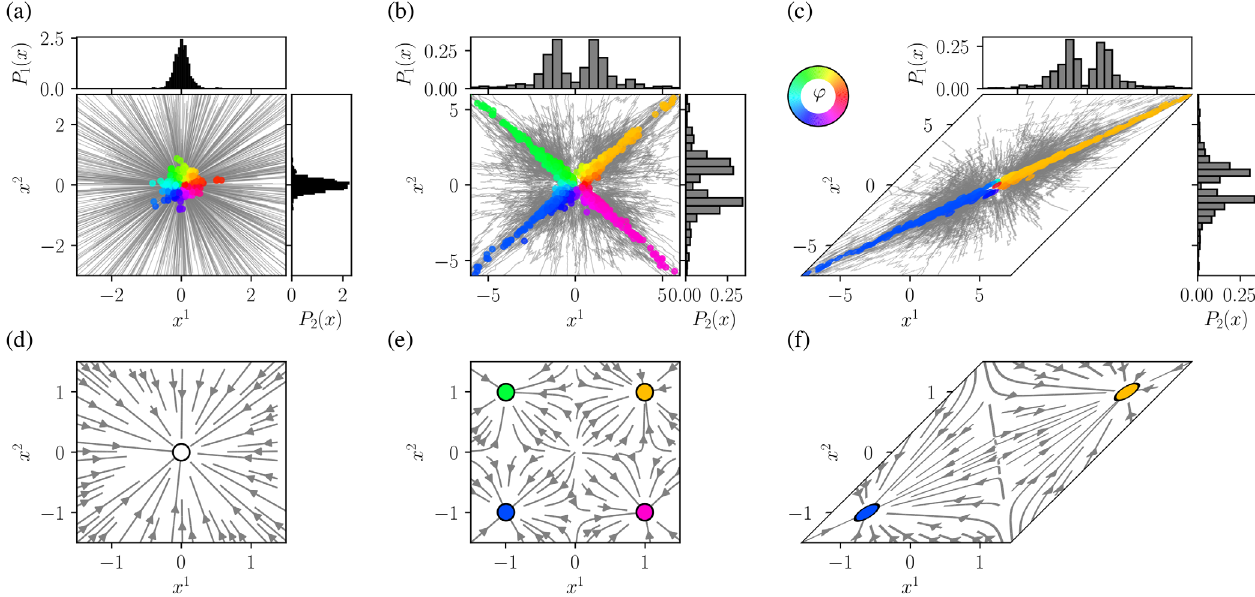
FIG. 2. Temporal evolution of the agents ’ opinions in a T ¼ 2 topic space. Evolution of opinions from numerical simulations (a) – (c) and corresponding deterministic dynamics (d) – (f) from mean-field approximation, with identical values of α and δ ; cf. Appendix B for details. The trajectories of the agents ’ opinions are depicted as gray lines, and final opinions are colored according to φ . The system reaches a global consensus if topics are not controversial, for small α ¼ 0 . 05 (a), while polarization emerges for controversial topics, for larger α ¼ 3 (b),(c). This result is indicated by the marginal distributions P u ð x Þ and P v ð x Þ : The values of the variances are σ 2 u ð x Þ ¼ 0 . 04 and σ 2 v ð x Þ ¼ 0 . 035 in (a), σ 2 u ð x Þ ¼ 7 . 27 and σ 2 v ð x Þ ¼ 7 . 17 in (b), and σ 2 u ð x Þ ¼ 11 . 22 and σ 2 v ð x Þ ¼ 11 . 2 in (c). If topics do not overlap ( δ ¼ π = 2 ), all combinations of opinion stances appear in consensus (a) and uncorrelated polarized states (b) with low correlation values of ρ ð x ð u Þ ; x ð v Þ Þ ¼ 0 . 01 (a) and ρ ð x ð u Þ ; x ð v Þ Þ ¼ 0 . 024 (b), respectively. If topics overlap [ δ ¼ π = 4 matching the angle between x and y axis in (c)], opinions become correlated and ideological states